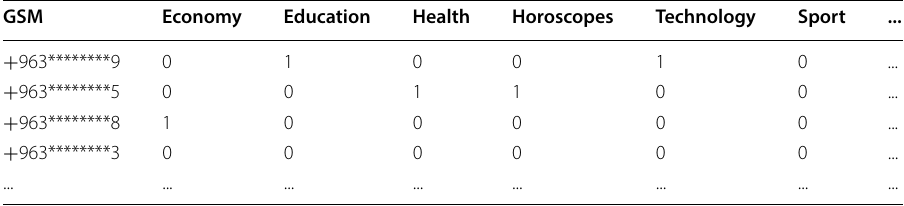
Table 3 Sample of customer’s